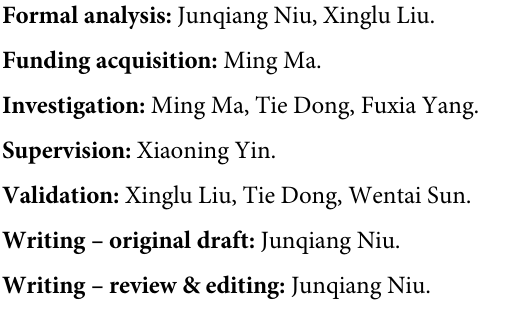
S2 Table. Photosynthetic related physiological indexes of apple leaves after reduce density. S3 Table. Summary of the RNA sequencing data. S4 Table. Statistical distribution of FPKM interval values in each sample. S5 Table. KEGG analysis of DEGs in LD and HD. S1 Fig. Plant hormone signal transduction pathway and related genes. A. Differentially expressed genes enriched in plant hormone signal transduction. Red represents up-regulated genes maped to this node, green represents down regulated genes maped to this node, yellow represents both up-regulated genes and down-regulated genes maped to this node. B. Cluster heat map of differentially expressed genes related to plant hormone signal transduction path- way. The horizontal axis showed the name of different comparison groups, and the vertical axis represent different